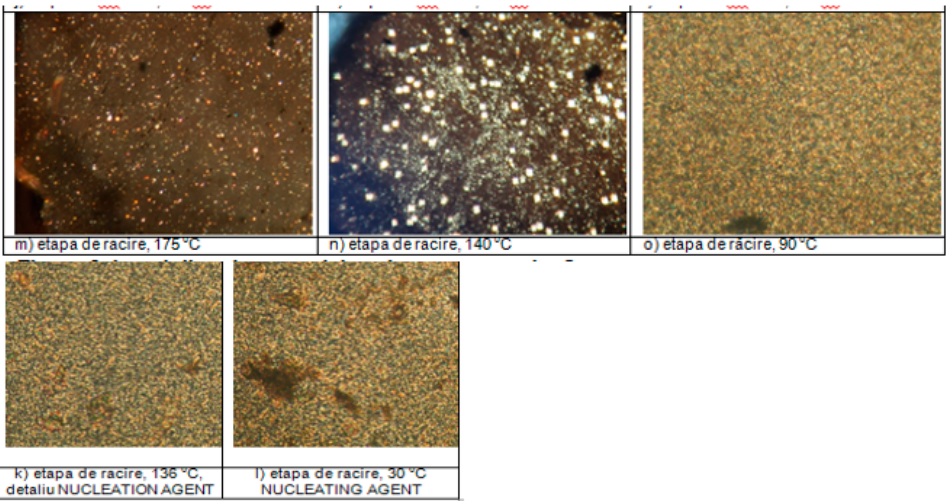
Figure 1. Polarized Light Microscopy (PLM) images of polylactic acid (PLA) without and with nucleation